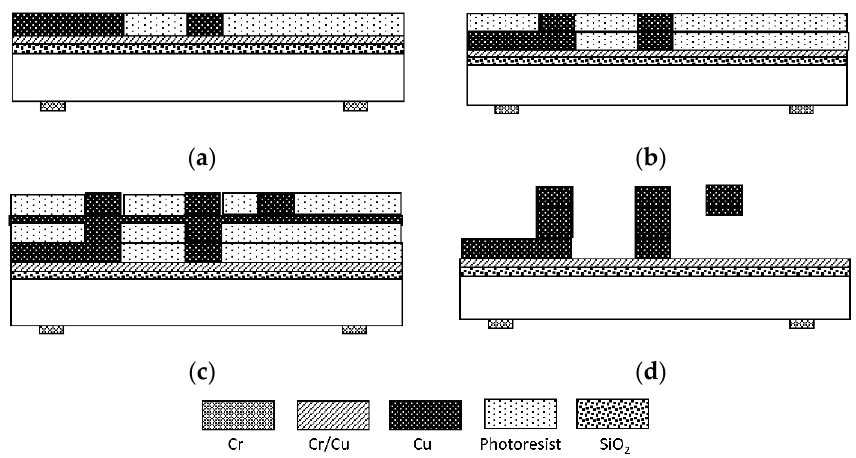
Figure 6. Fabrication process of the MEMS suspended inductor. ( a ) Seed layer deposition, photoresist (PR) mold patterning and copper electroplating, ( b ) PR mold patterning and copper electroplating, ( c ) Seed layer deposition, PR patterning and copper electroplating, ( d ) PR strip and seed layer etch.